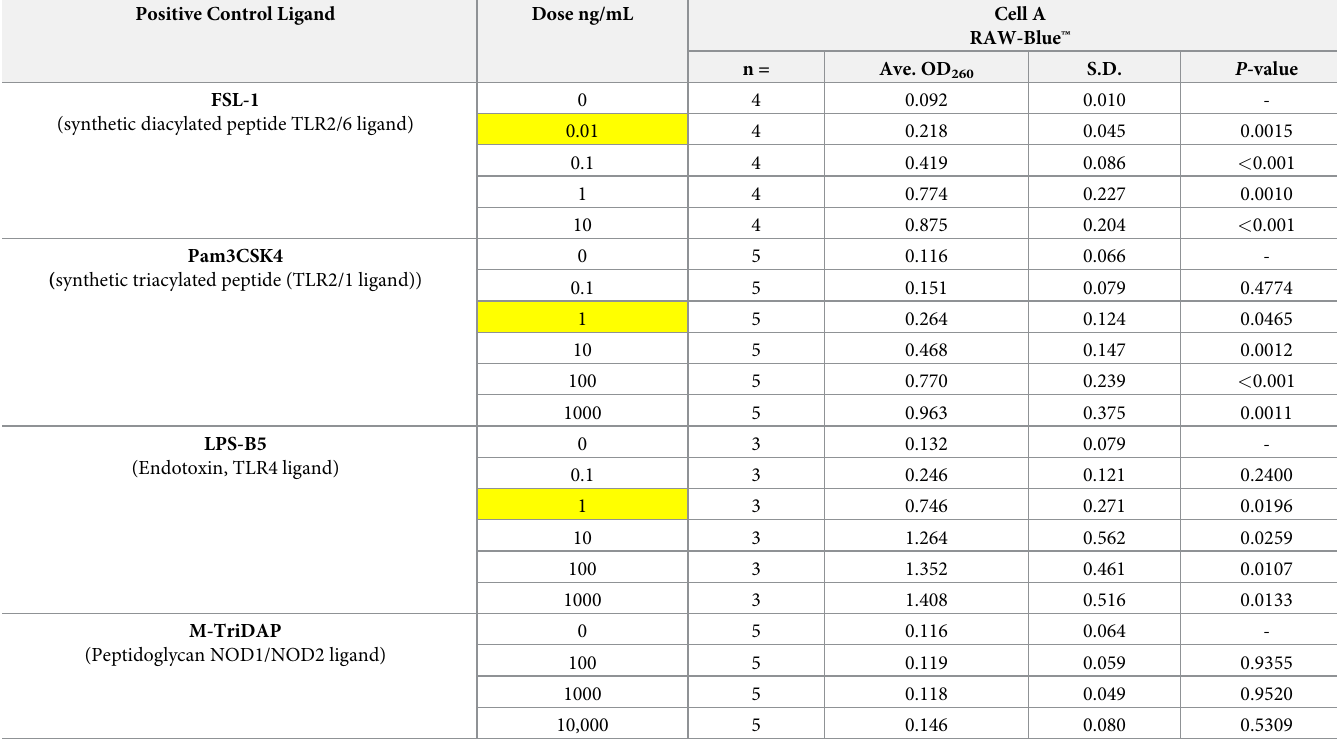
Table 2. Positive control testing of RAW-Blue ™ cell line sensitivity.